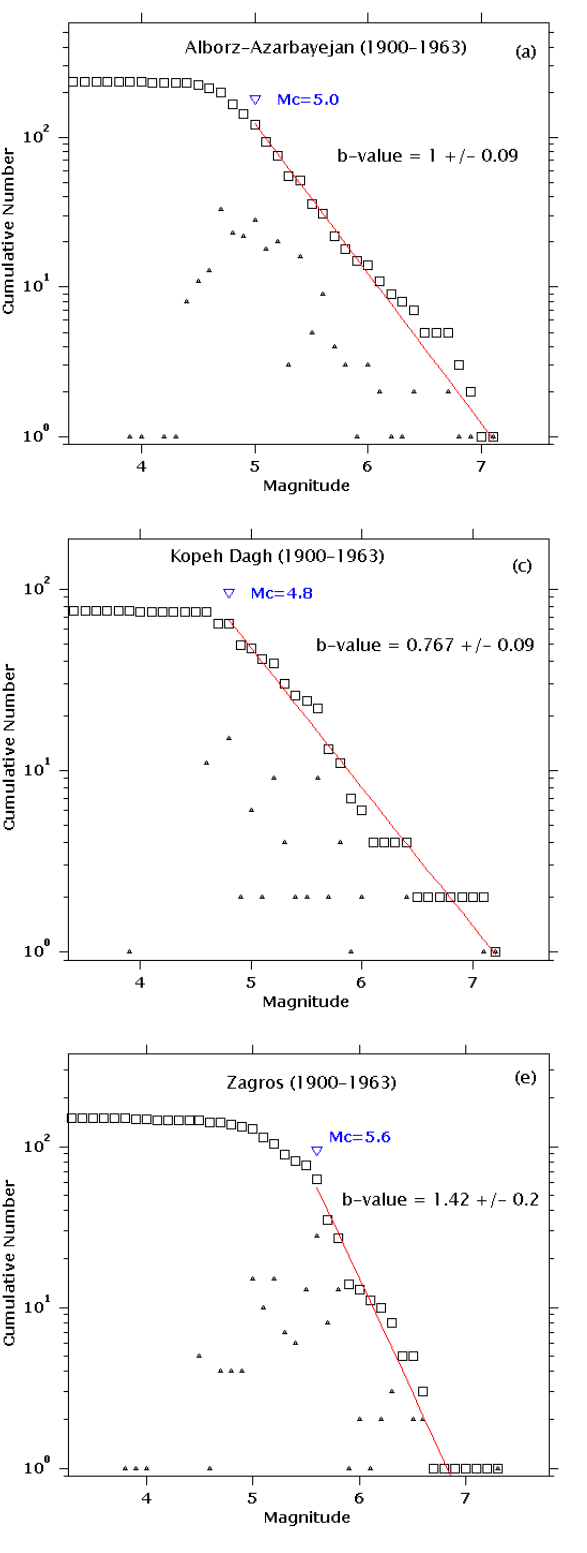
Figure 14. Magnitude of completeness M and b-value for time interval 1900–1963 by using EMR method for the declustered catalog in c major seismotectonic provinces in Iran and the total